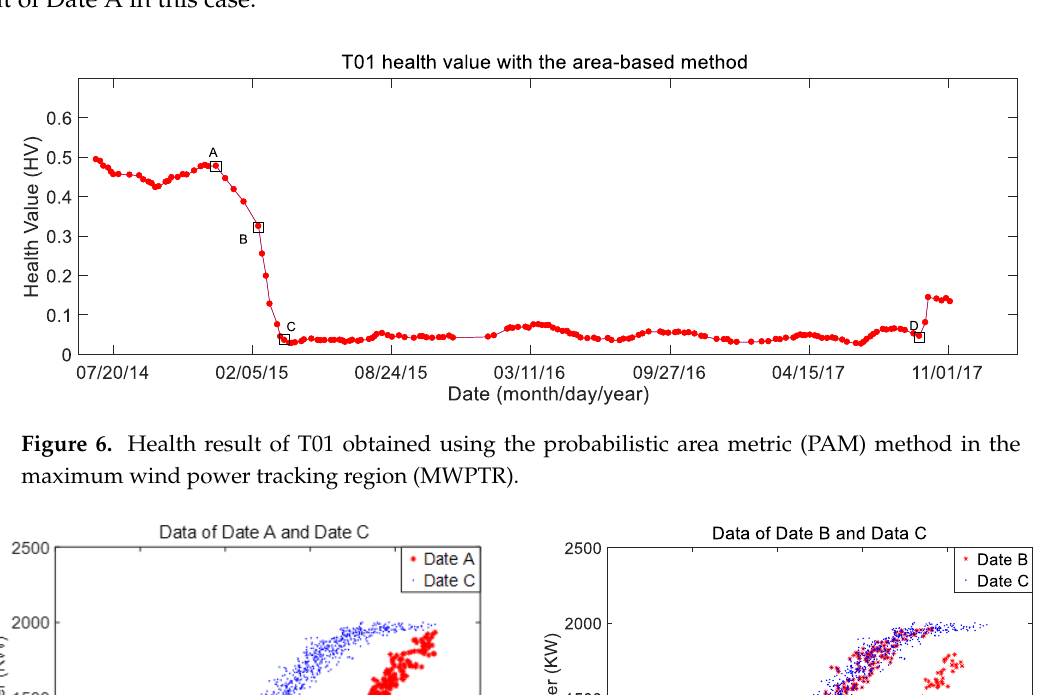
Figure 5. Method to update time window. 4. Verification of Results 4.1. MWPTR Results The SCADA data used in this study are obtained from a mountain wind farm which has 24 sets of 2 WM wind turbines. The cut-in wind speed